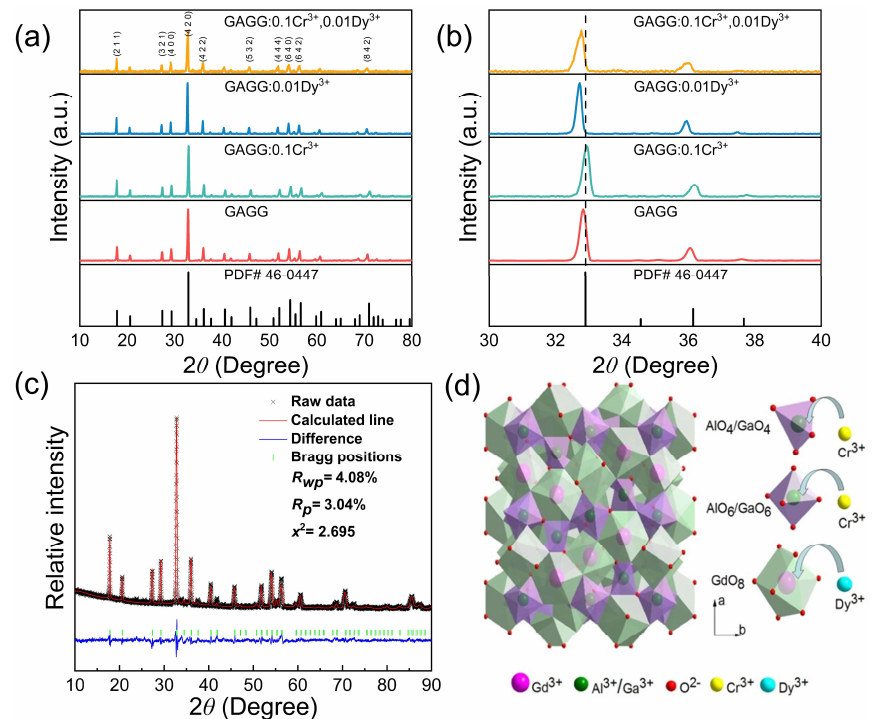
Figure 1. ( a ) XRD of GAGG, GAGG:Cr 3+ , GAGG:Dy 3+ and GAGG:Cr 3+ , Dy 3+ ; ( b ) magnified XRD patterns in the 30–40 ◦ range; ( c ) XRD refinements of GAGG; ( d ) crystal structure of GAGG viewed along the a-axis.